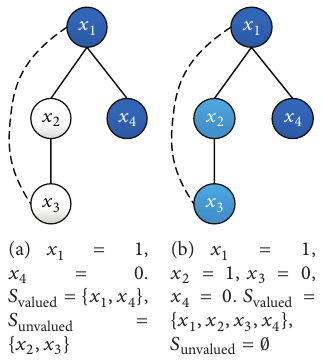
Figure 5: Construction of initial solution.